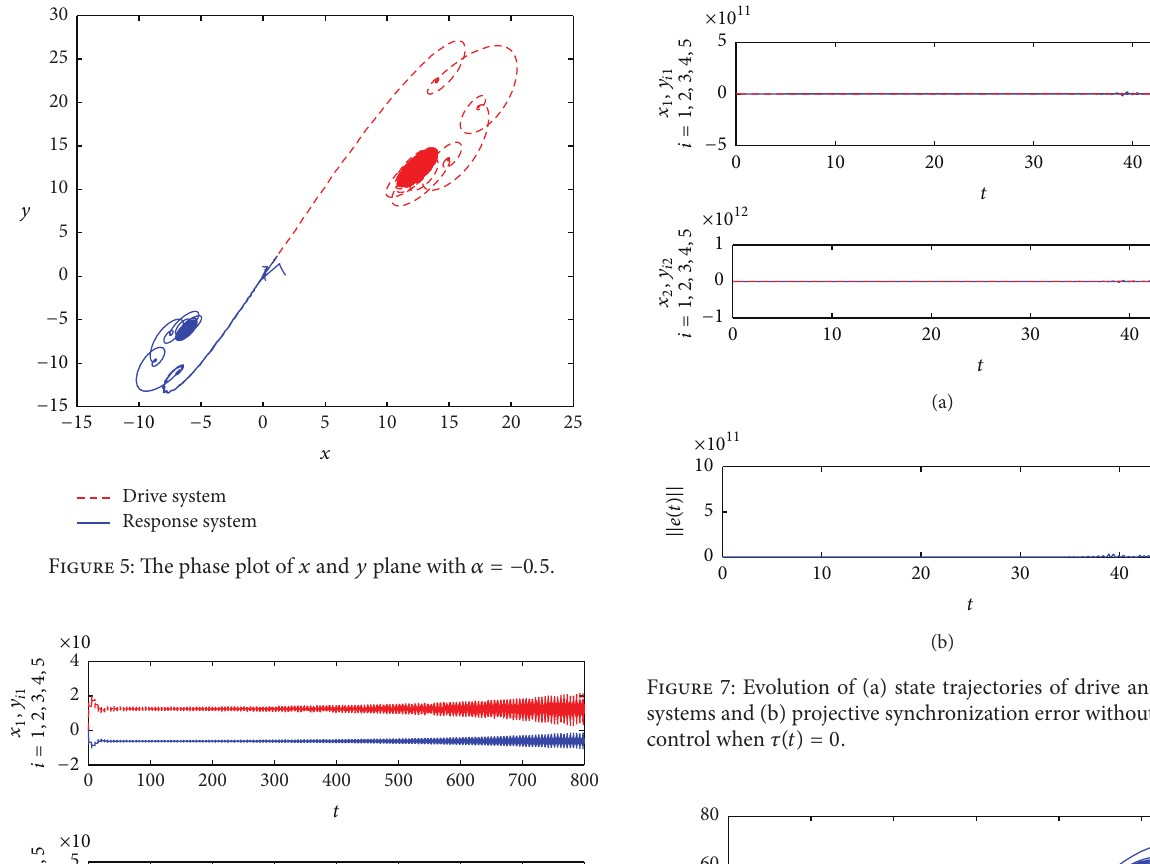
multiple time-varying delays is studied by employing the impulsive control scheme. As well known, compared